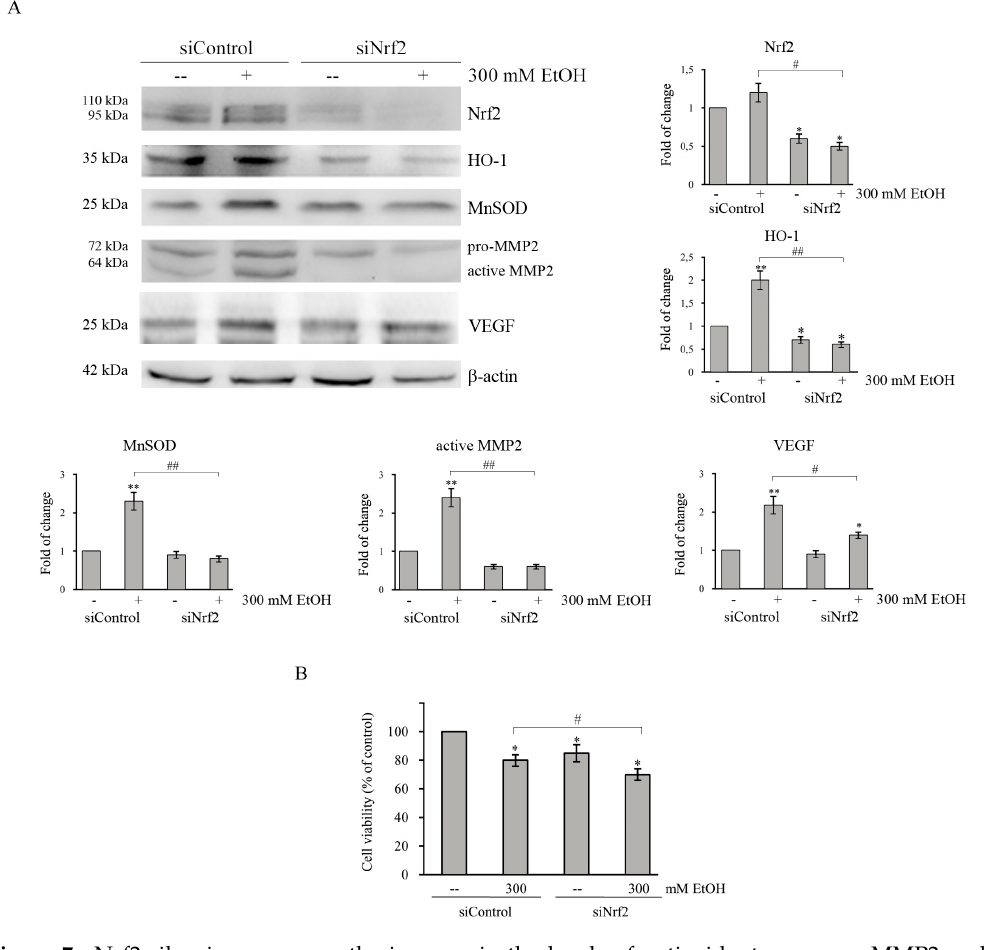
Figure 7. Nrf2-silencing represses the increase in the levels of antioxidant enzymes, MMP2 and VEGF induced by EtOH treatment. ( A , B ) HCT116 cells (1 × 10 5 ) were transiently transfected with a nonspecific siRNA (siControl) or with Nrf2 specific siRNA pool (siNrf2) and, 24 h after transfection, cells were treated with 300 mM EtOH for additional 24 h or 48 h. ( A ) The levels of HO-1, MnSOD, MMP2, and VEGF were analyzed by Western blotting after 24 h of transfection. The successful of Nrf2-silencing was verified by measuring the level of Nrf2 in transfected cells. Quantitative estimations of the protein levels were determined by densitometry measurements of western blotting from three independent experiments after normalization with β -actin (*) p < 0.05 and (**) p < 0.01 compared to the untreated sample. ( # ) p < 0.05, ( ## ) p < 0.01. ( B ) Effects of Nrf2-silencing on the viability of HCT116 cells evaluated after 48 h of EtOH treatment by MTT assay and expressed as the percentage of the ± S.E. ( # ) p < 0.05 between the two